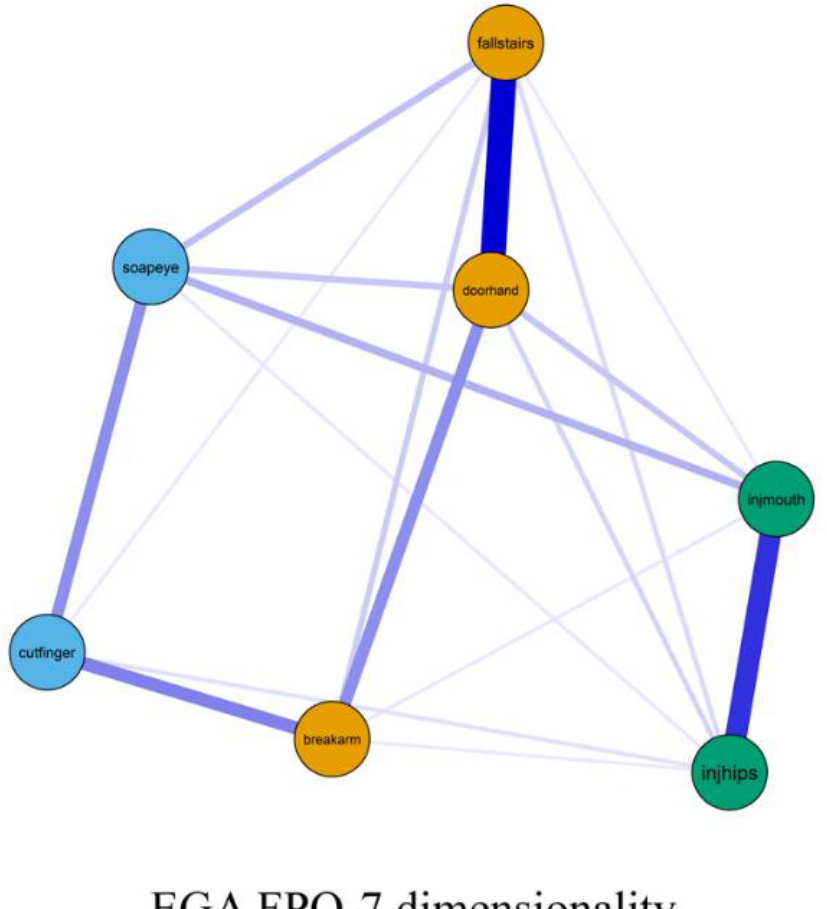
Figure 2. Network of the Fear of Pain Questionnaire-7 (IA-FPQ-7). Note: Nodes were coloured according to the EGA-identified dimensions, which corresponded to the theoretical dimensions of Fear of Medical/Dental Pain ( green ), Fear of Minor Pain ( blue ), and Fear of Severe Pain ( orange ). Positive edges are displayed as blue lines, and negative edges are displayed as red lines. Edge weights are represented by the thickness and saturation of the edges.